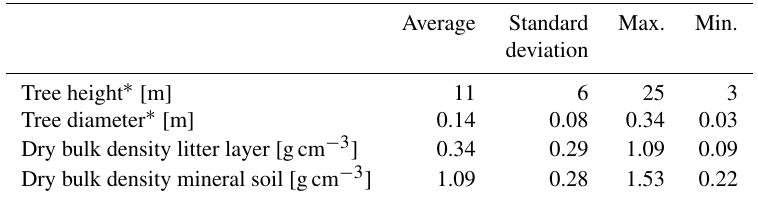
Table 2. Average tree height, tree diameter and dry bulk density (bd dry ) of the litter layer and the mineral soil at Gludsted plantation field site. Tree height and diameter are representative of conditions for year 2012.